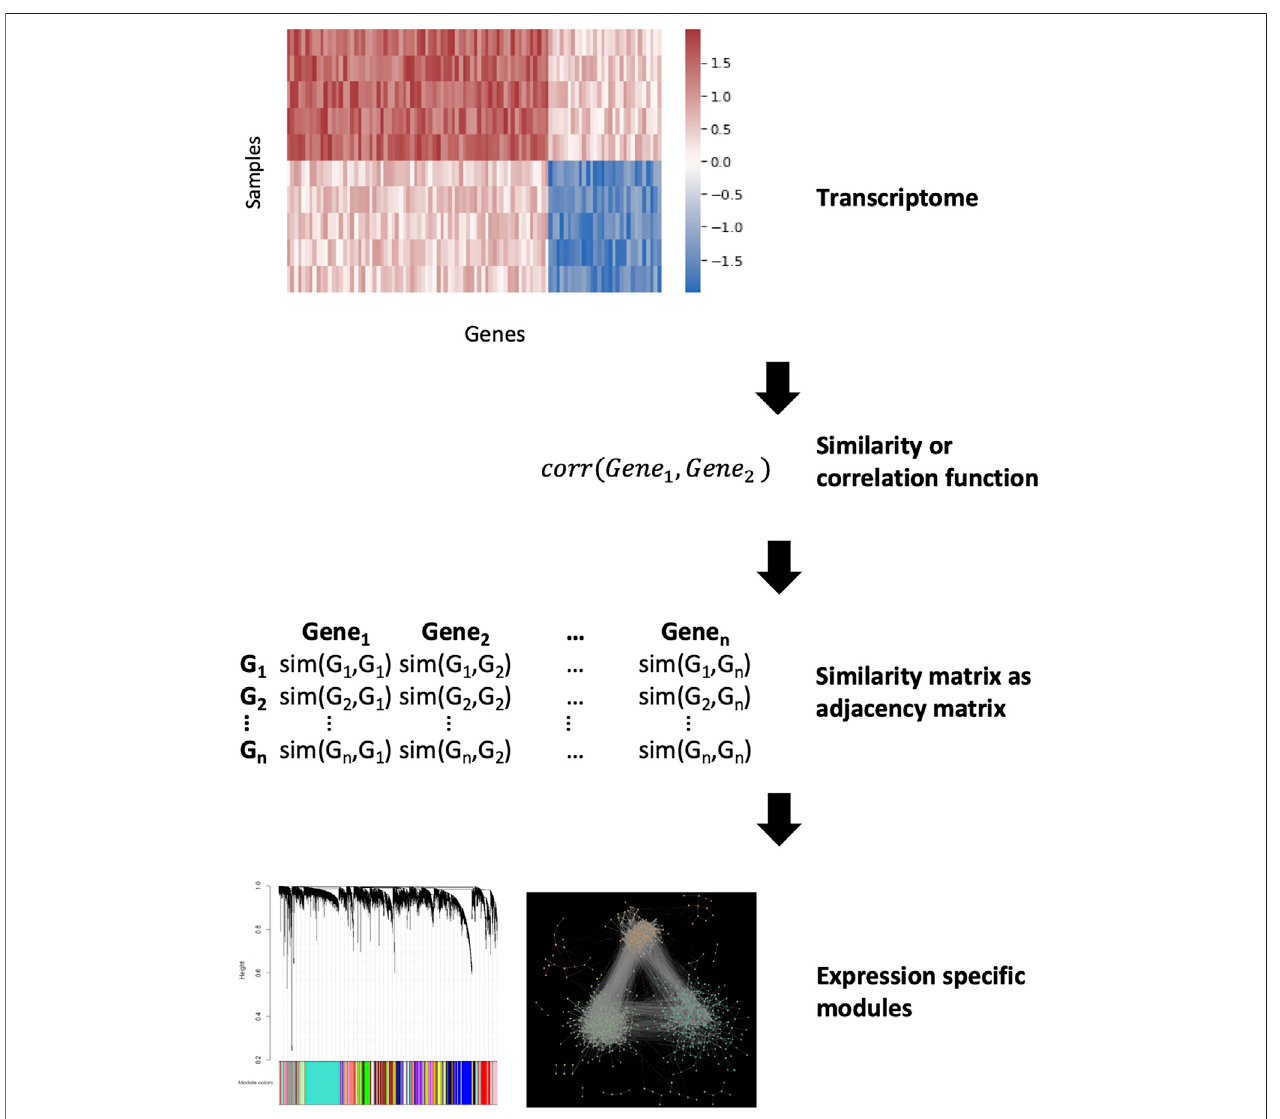
FIGURE 5 | Gene co-expression network analysis. Calculating a similarity between the genes from expression data can be used as an adjacency matrix in a co- expression network. The similarity function depends on the used method but after that the most similar parts of the network can be denoted as modules.